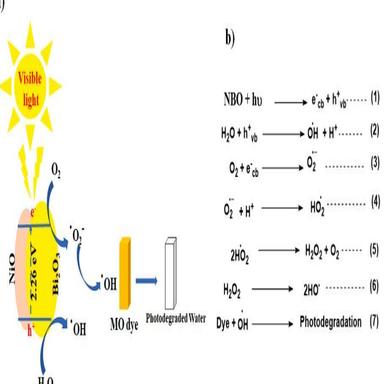
Efficiency of the NBO upon reusable with four cycles of photodegradation MB and MO dyes.